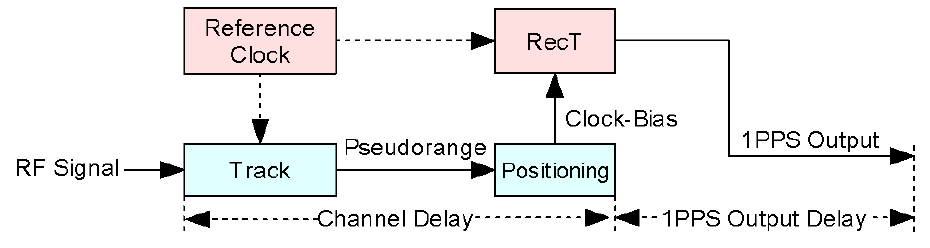
Figure 2. Composition of the receiver delay.